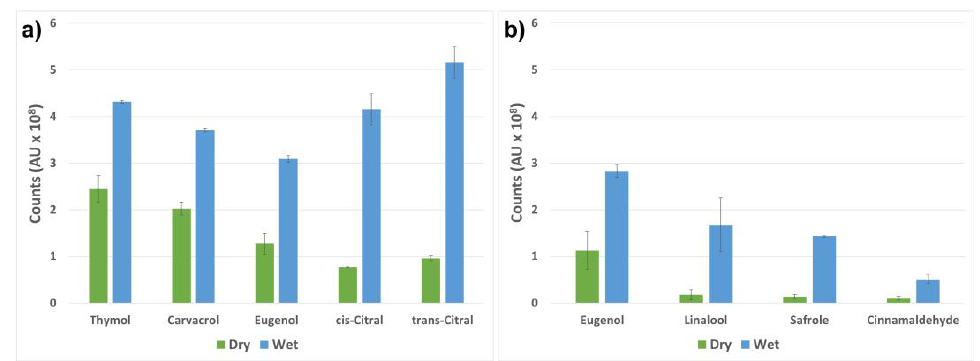
Figure 6. Headspace analysis of the volatile compounds released from the nanocarriers before (dry) and after (wet) activation by buffer solution. The samples were standing for 30 min at room temperature prior to the measurements. The data are presented as the peak areas of the detected compounds vaporized from the nanocarriers. The nanocarriers loaded with pure compounds (thymol, carvacrol, eugenol and citral) are shown in ( a ), while ( b ) presents four of the highest peaks obtained from the nanocarriers loaded with cinnamon